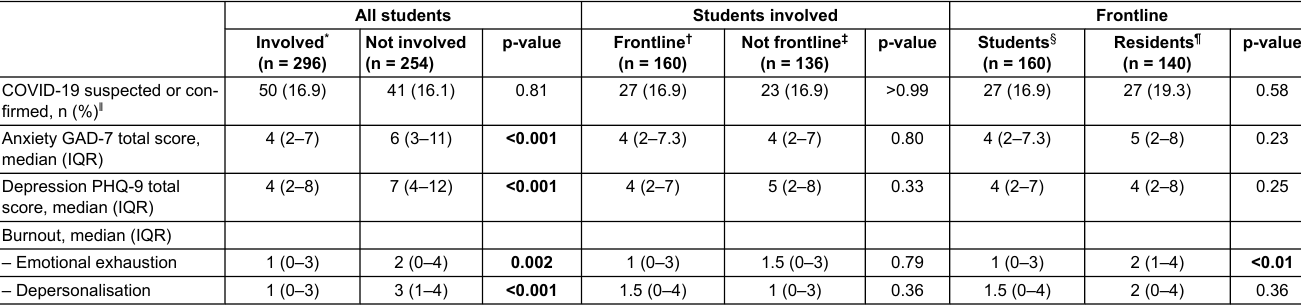
Table 2: Suspected or confirmed COVID-19, symptom levels of anxiety, depression and burnout in medical students and residents.